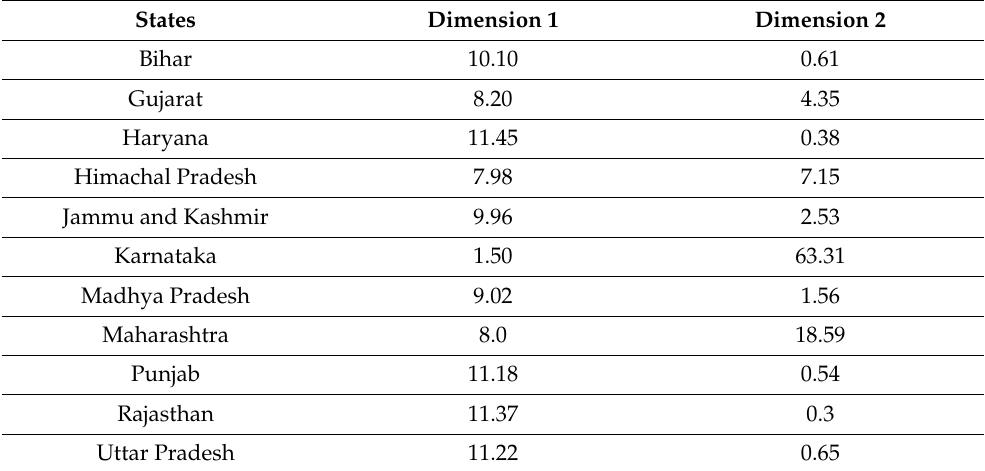
Table 2. Production principal components.